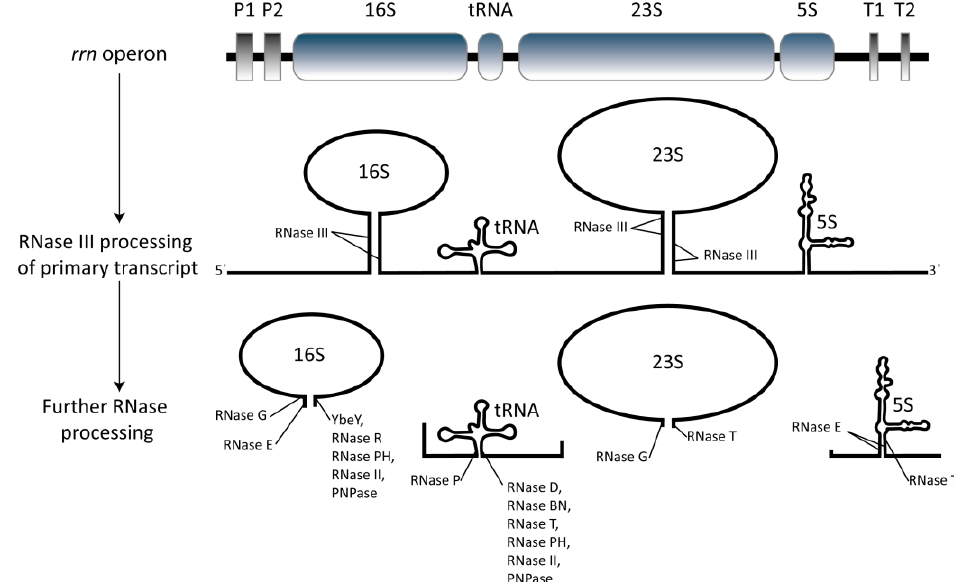
Figure 1. Schematic overview of rRNA production in prokaryotes using E. coli as an example. Production initiates with the transcription of a typical rrn- encoded rRNA operon by RNA polymerase into a single polycistronic transcript encoding 16S, tRNA, 23S and 5S (the presence of tRNA depends on the operon). Processing begins concurrently with transcription, with r-proteins and secondary rRNA structures beginning to assemble while chemical modifications occur. RNase III cleaves the primary transcript into the pre-16S (17S), pre-23S (25S), pre-tRNA and pre-5S through recognition of helical stem loops. Subsequent processing to generate mature rRNA is carried out by a range of ribonucleases as indicated, which di ff er depending on the organism. Enzymes involved in the 3 (cid:48) processing of tRNA di ff er depending on the tRNA family and 3 (cid:48) immature region in question